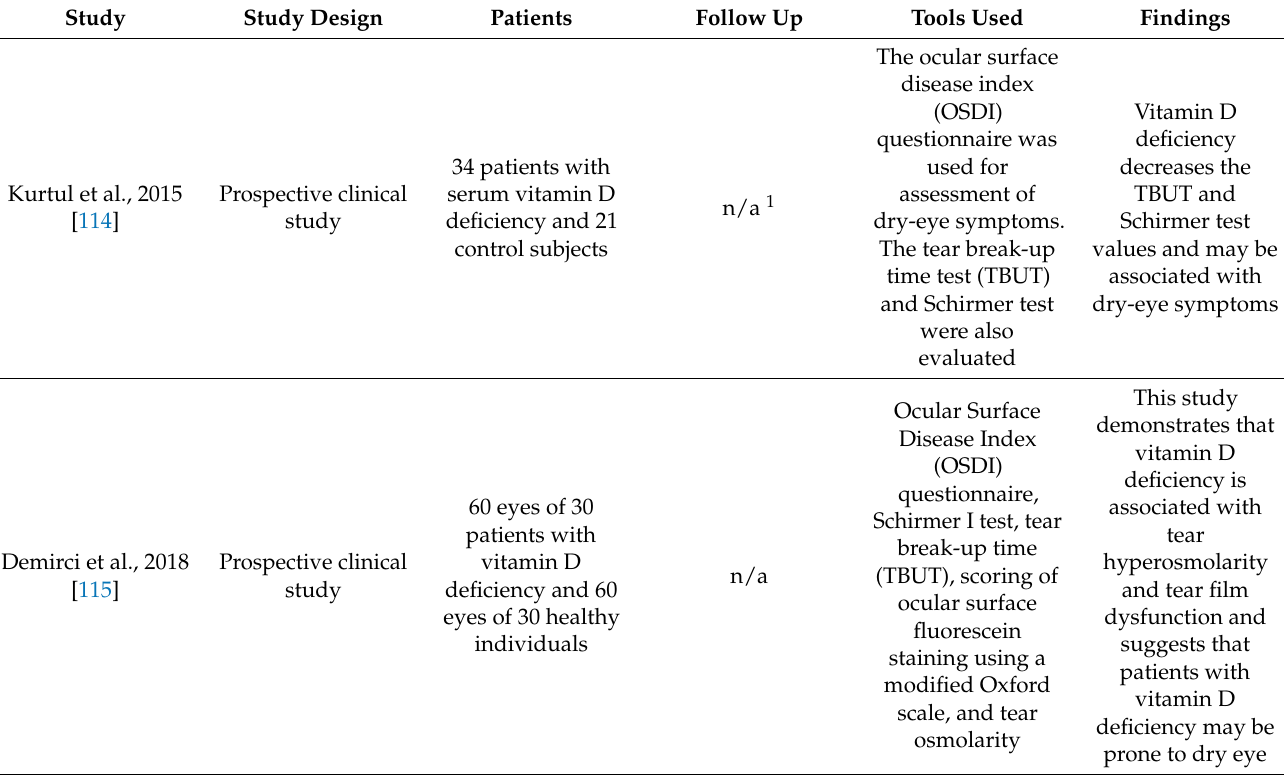
Table 1. Clinical studies on the role of vitamin D in